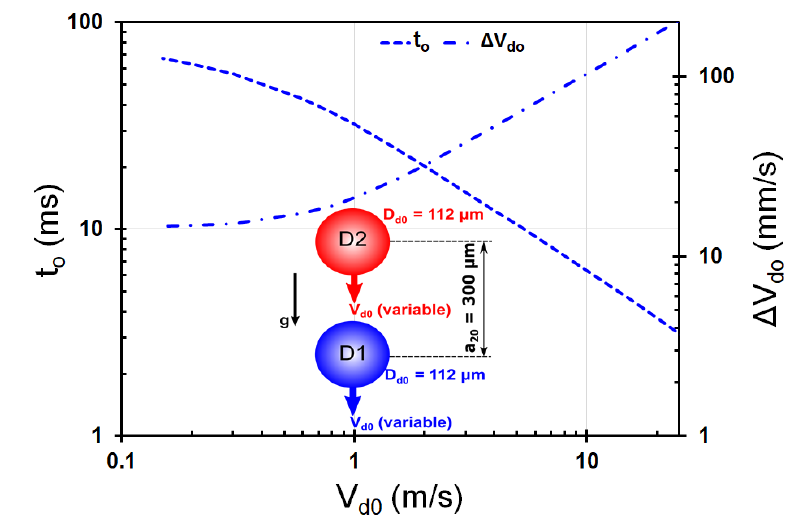
Figure 10. Effect of V d 0 on t o and ∆ V d 0 : The effect of the initial droplet velocity on the time taken by the droplets to come in contact with each other for the first time and their approach velocity at this instant. Other parameters are the same as in Figure 4: D d 0 = 112 µ m; a 20 = 300 µ m; C D is calculated using Equation (10). The ranges of the initial values of Reynolds number and aerodynamic Weber number are 1.1–185.6 and 1.39 × 10 − 4 –3.87,